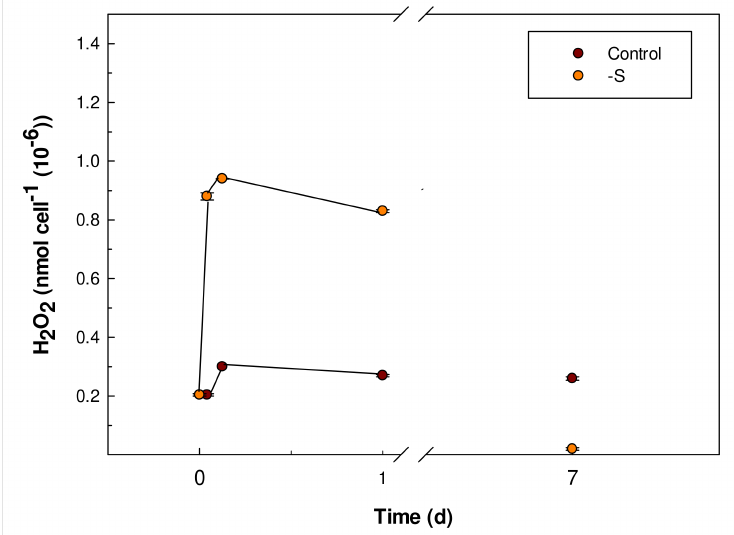
Figure 6. Hydrogen peroxide intracellular contents in control and S starved (-S) cells of Galdieria sulphuraria . The H 2 O 2 levels were measured during the experiment at 0, 1, 3 h and at 1 and 7 days and expressed as nmol cell − 1 × 10 6 . Error bars represent SD ( n =